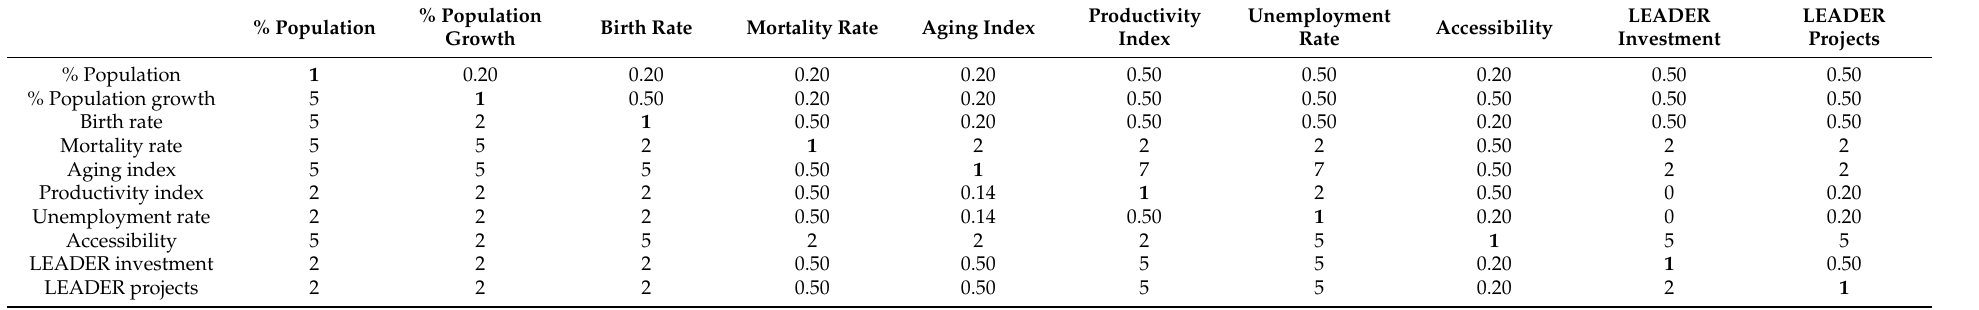
Table 5. Normalized pairwise comparison matrix